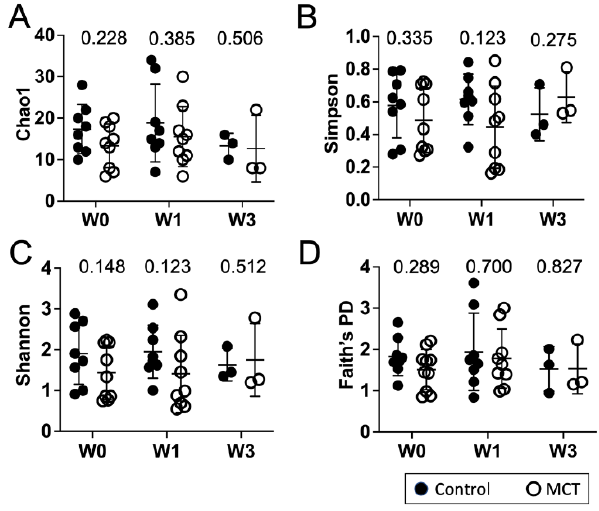
Figure 1. Infant gut microbiota diversity is not impacted by MCT supplementation. Stool samples were collected from infants before (Week 0), or after 1 or 3 weeks of supplementation with MCT. Control infants were sampled at the same times but did not receive MCT. Bacterial composition of control and MCT-supplemented infants over three weeks was analyzed by 16S rDNA sequencing, followed by QIIME2 analysis. Diversity scores were calculated. The bar represents the mean diversity score with the standard deviation, for all infants within a group. ( A ) Chao1, ( B ) Simpson, ( C ) Shannon, and ( D ) Faith’s PD. Black circles denote control infants. Open circles denote MCT-supplemented infants. Mann–Whitney p -values are displayed above each